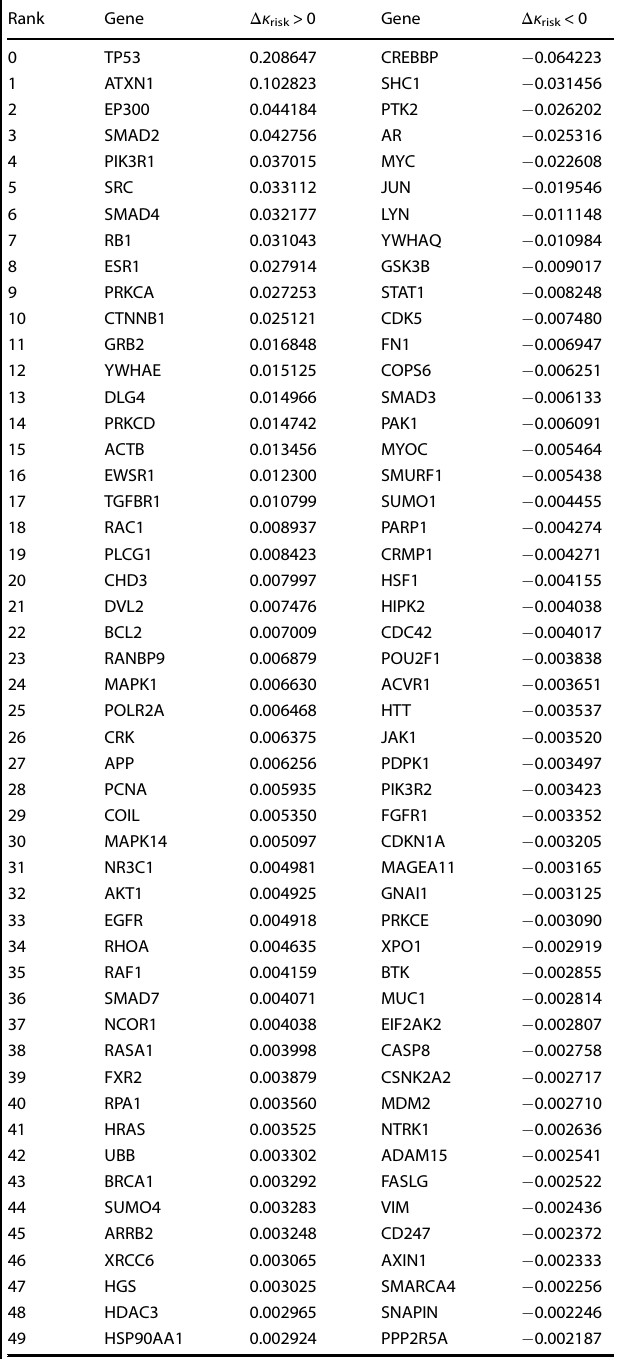
Top 50 genes ranked by positive ( Δ κ risk >0) and negative ( Δ κ risk <0) difference in average scalar curvature between low risk ( n = 33) and high risk ( n = 12)